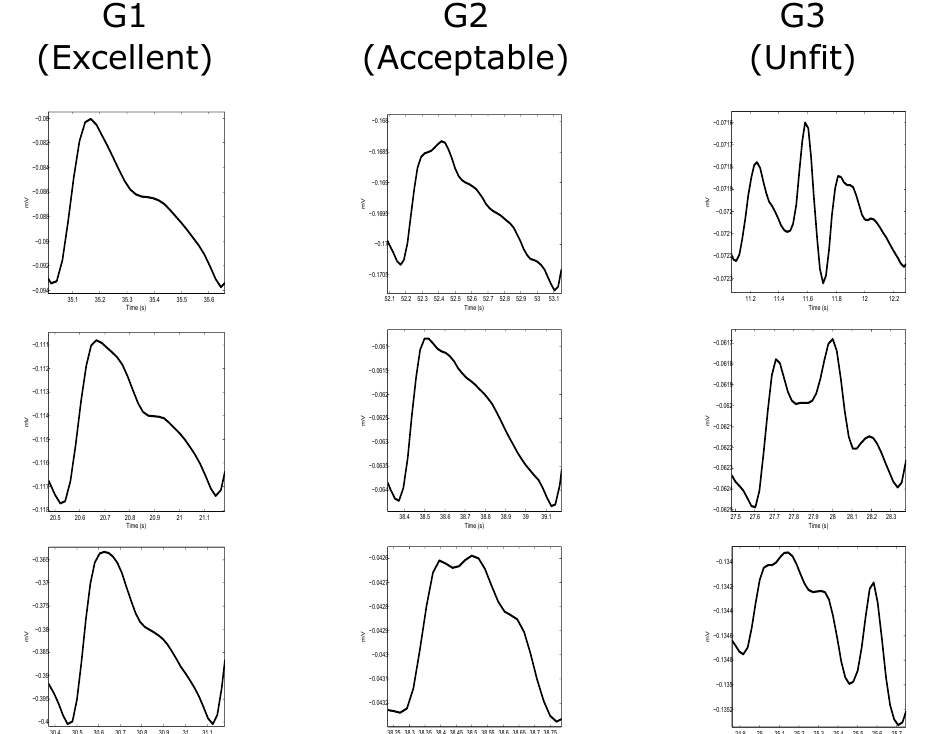
Figure 1. Annotation of photoplethysmogram (PPG) signals. Annotating the whole signal is based on the most dominant beat wave quality within the signal. The most dominant beats waves were categorized into three categories: G1 contains beats clear systolic and diastolic waveforms with dicrotic notches; G2 contains beats without clear systolic and diastolic waveforms and without dicrotic notches; and G3 contains noisy waveforms. Each column represents a different group with three examples showing the whole PPG signal ( left side of each example) and its most dominant beat wave ( right side in each